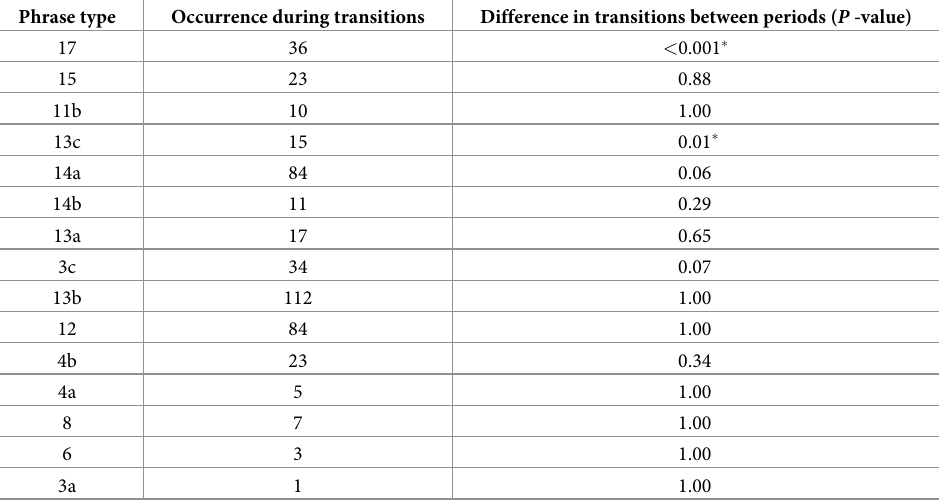
Table 2. Consistency of transitions of each phrase type between